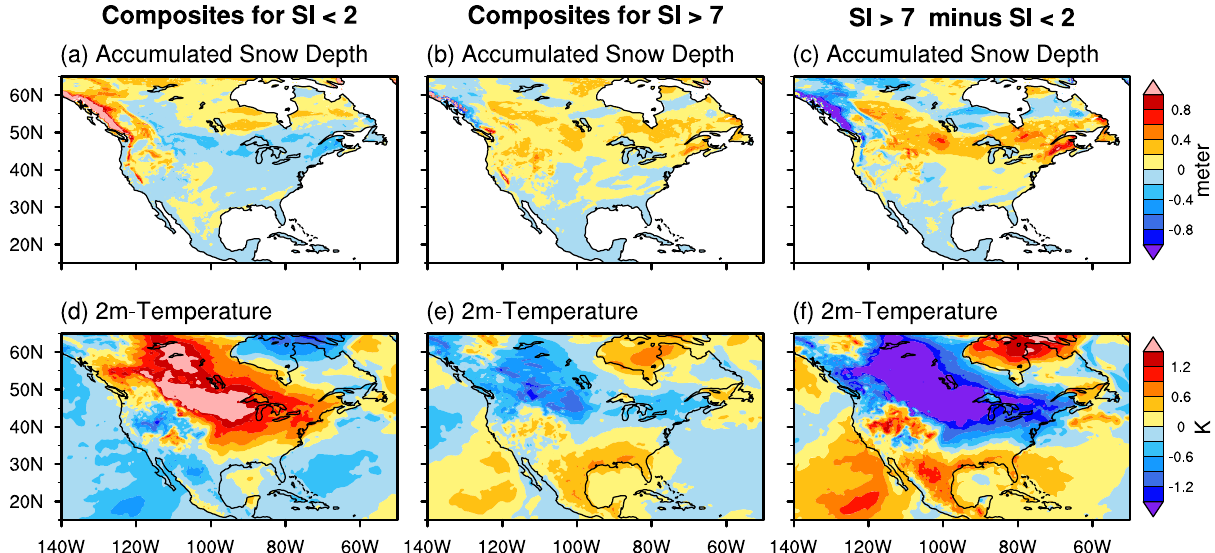
Fig. 4 Accumulated snow depth and near-surface temperature during years with mild and severe bloom activity. a Anomalies of accumulated snow depth (m) for years with HABs SI < 2. b Same as ( a ) but HABs SI > 7. c Anomalies of accumulated snow depth (m) for HABs SI > 7 minus HABs SI < 2. d Same as ( a ) but for 2 m temperature (K). e Same as ( b ) but for 2 m temperature (K). f Same as ( c ) but for 2 m temperature (K). These anomalies for December, January, and February were calculated after subtracting the climatology based on 2002 – 2020.